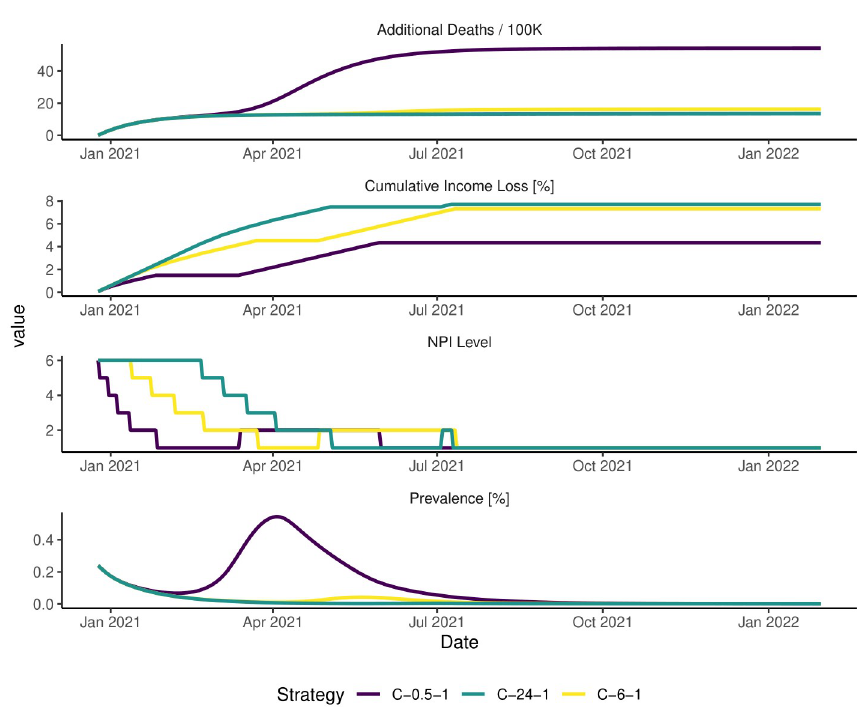
Fig 1. Model dynamics with adaptive NPI strategies in California. This figure presents three illustrative runs testing three strategies in an example future state of the world. Strategies are coded as follows throughout this paper. The first letter in the strategy code represents the strategy type (C for constant caution, T for time-based, and V for vaccine- based strategies). The subsequent number represents the baseline level of caution x b , and the third number is a sequential code to make the strategy code unique. The full list of strategies tested in this paper is provided in S1 Appendix. In this figure, the most stringent strategy, C-24-1 uses a level of caution x t = 24 throughout the simulation run. Strategy C-6-1 uses a level of caution x t = 6 and produces similar results, while strategy C-0.5-1 results in a substantial increase in deaths. None of these model runs represent a